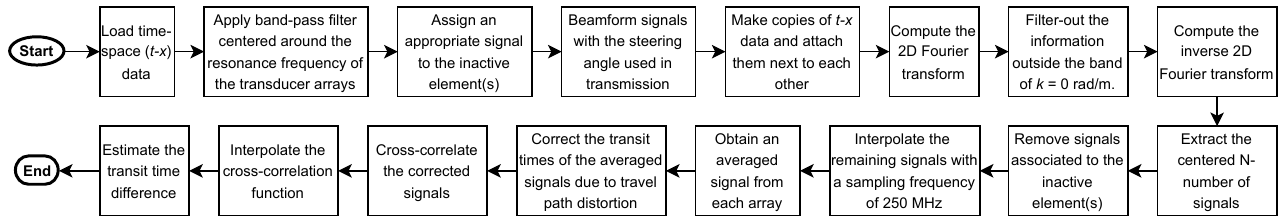
Figure 3. Flowchart of the designed algorithm to correct for the measurement offsets introduced by inactive (non-functioning/broken/damaged) elements during transducer array-based ultrasonic flow